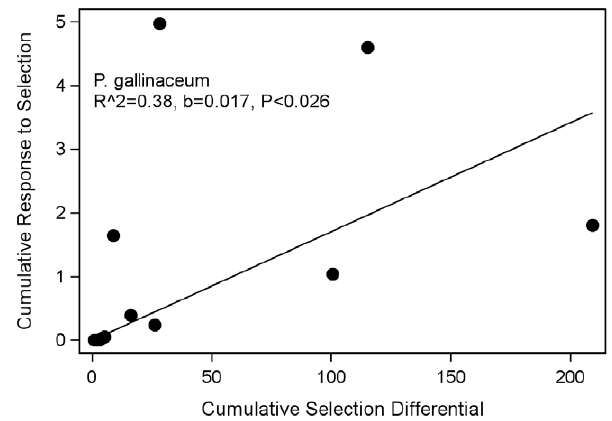
Figure 7. Response of P.gallinaceum selected for compatibility with An.stephensi based on mean oocyst load. The cumulative response to selection is regressed on the cumulative selection differential for the selected An. stephensi lines. Regression is forced through the origin.